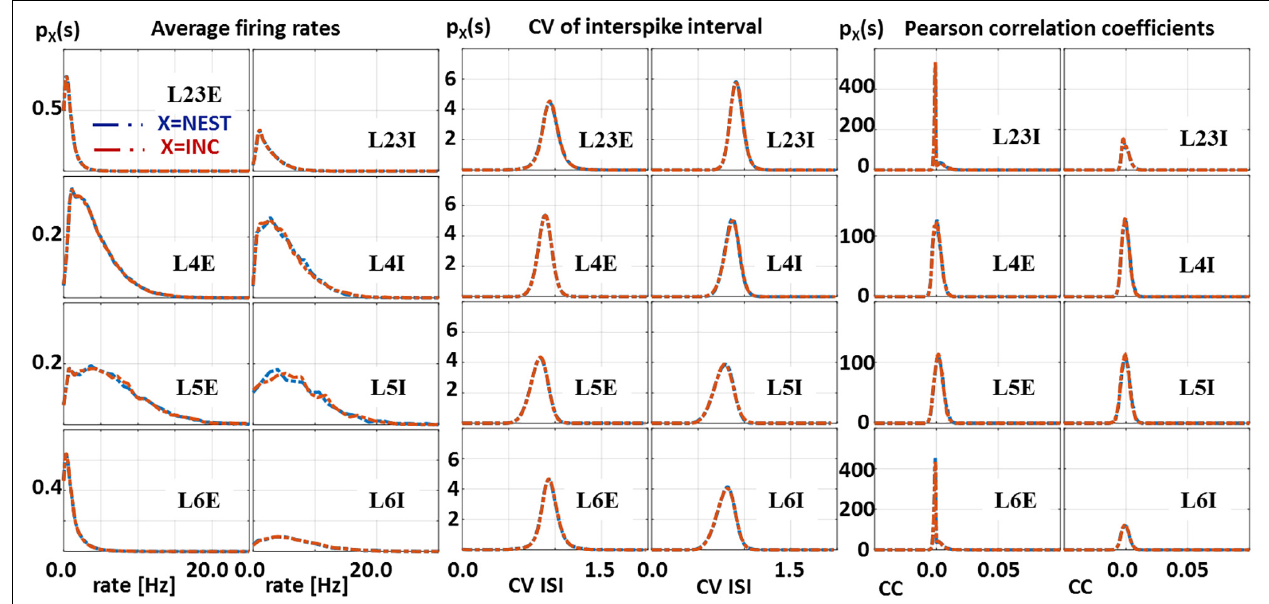
FIGURE 9 | Substantiation assessment: Quantitative comparison of three characteristic measures from 15 min. network activity obtained from simulations of the cortical microcircuit on the IBM INC-3000 Neural Supercomputer and the NEST simulator. Probability distributions from left to right: average firing rate (FR), coefficient of variation (CV), and Pearson’s correlation coefficient (CC), spike trains are binned on a fine temporal scale of 2 ms. All measures for all layers of the cortical microcircuit are in close